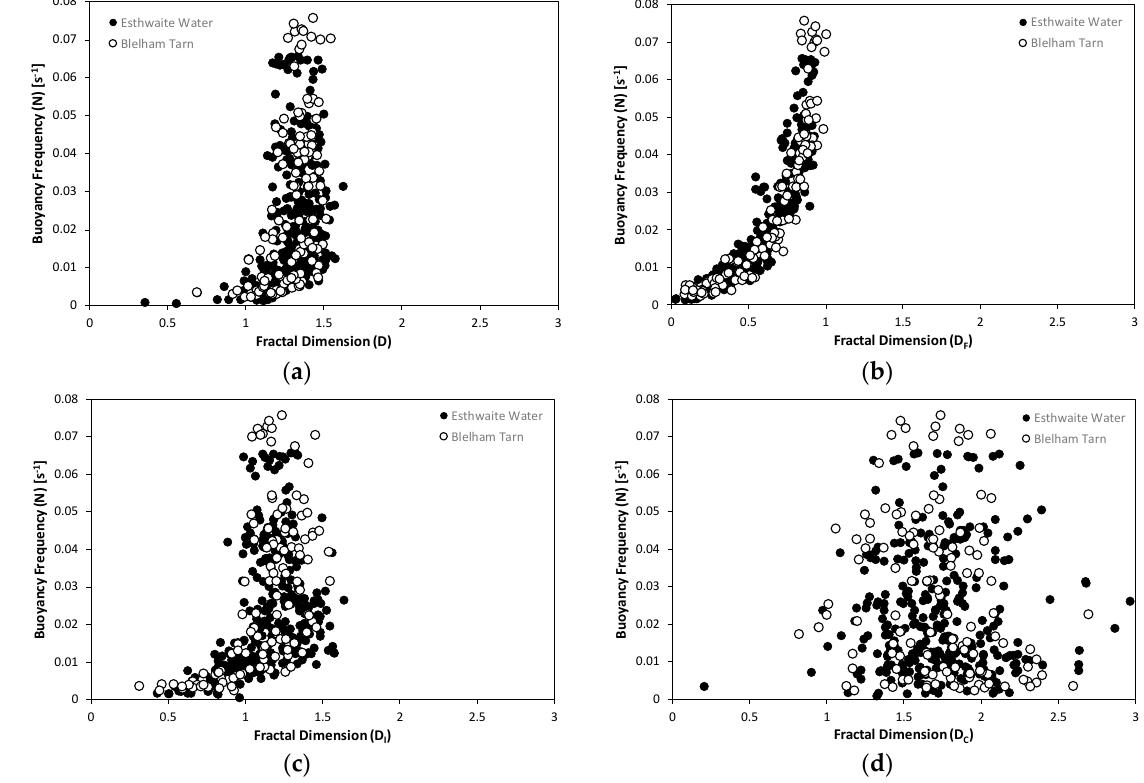
Figure 10. Plots of buoyancy frequency against ( a ) D; ( b ) D F ; ( c ) D I ; and ( d ) D C . Data from all depths bins, all profiles and all dates combined.